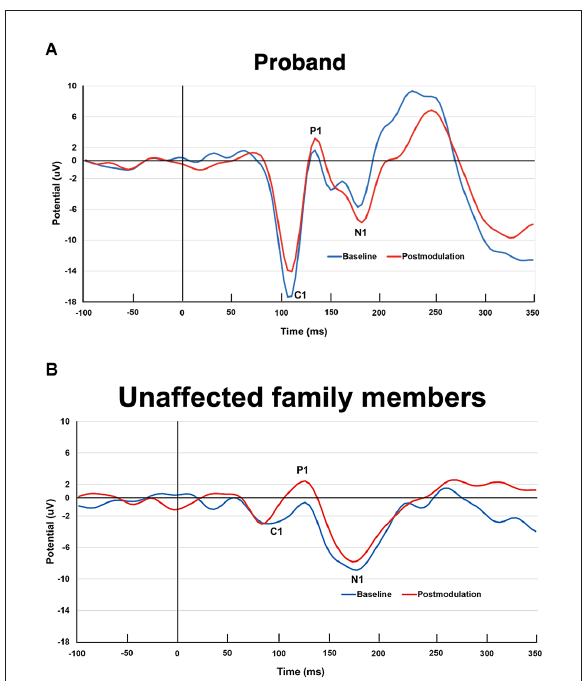
FIGURE6 (A) Visual evoked potentials (VEPs) elicited by checkerboard reversal stimulation at baseline (blue color) and postmodulation (i.e., after a plasticity inducing intervention of prolonged visual stimulation for 10 min; red color) in the 3q29 deletion